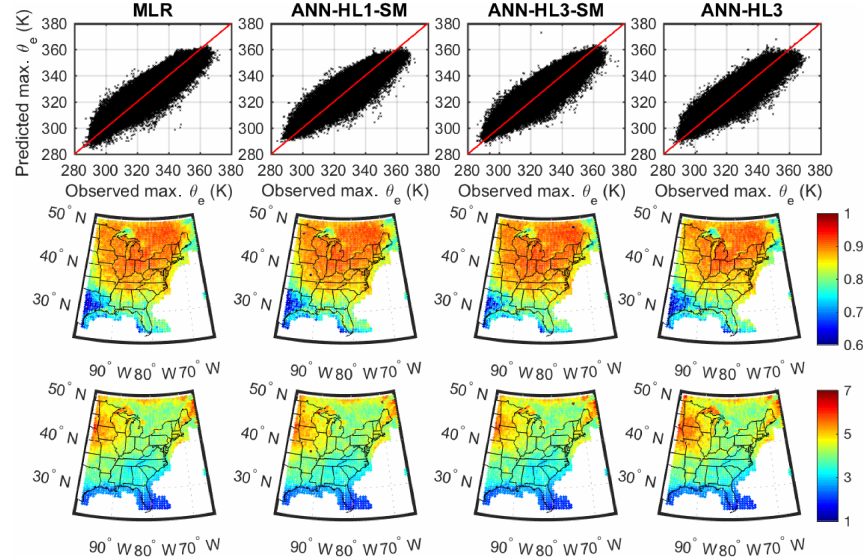
Figure 4. Précis of the downscaling model performance for daily maximum θ e (max. θ e ). The upper panels show scatter plots of observed and predicted maximum θ e for all grid cells and all days within the test (independent) data, along with a red 1:1 line. The columns show results for four model configurations: multiple linear regression (MLR, left), ANN with one hidden layer (ANN-HL1-SM, second column), ANN with three hidden layers (ANN-HL3-SM, third column) and ANN with three hidden layers but excluding information regarding the soil moisture (ANN-HL3, right column). The second row shows the Pearson correlation ( r ) of predicted and observed maximum θ e values in the independent data for the four different models, while the third row shows the mean root mean square error (RMSE) (K) computed for independent data from each grid cell for the four models. Results for ANN-HL3-TOP are virtually identical to those for ANN-HL3-SM and thus are not shown.